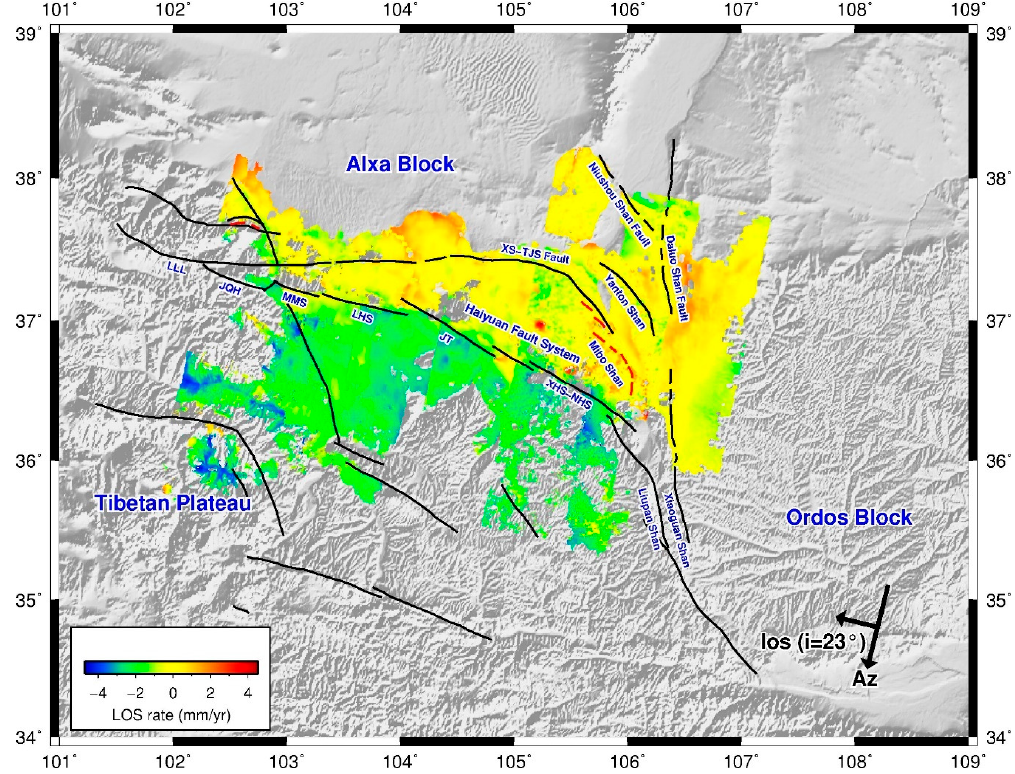
Figure 6. InSAR Mean LOS ratemap for 6 tracks covered the northeastern margin of the Tibetan Plateau, produced by stacking the atmospheric-corrected interferograms. LLL: Leng Long Ling, JQH: Jing Qiang He, MMS: Maomao Shan, LHS: Laohu Shan, JT: Jing Tai, XHS-NHS: Xihua Shan-Nanhua Shan, XS-TJS: Xiang Shan-Tianjing Shan.